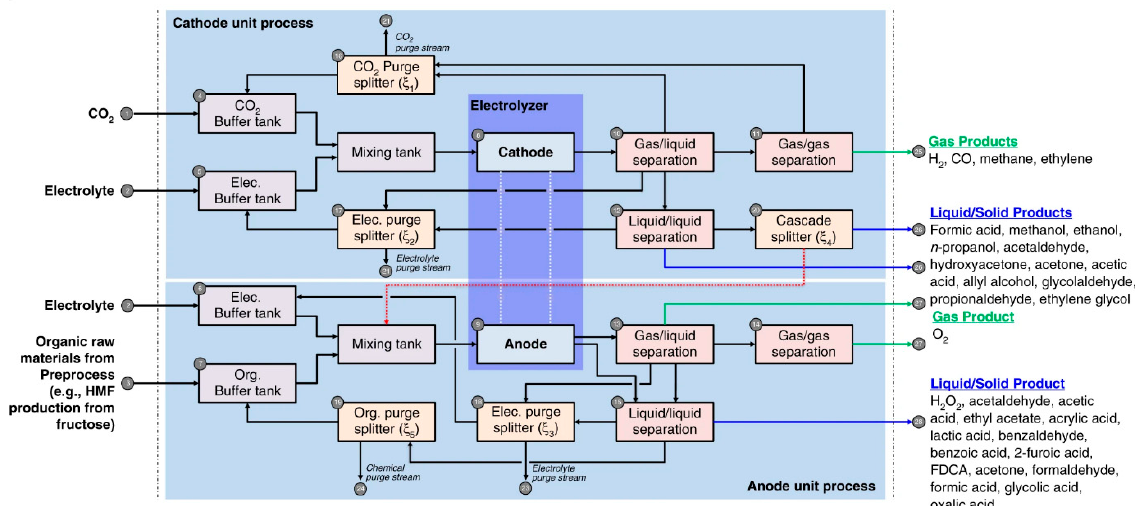
Figure 7. The superstructure of the electrochemical coproduction process is used to simultaneously consider all possible structures of the process. Reproduced with permission from ref. [7], copyright 2019, Springer Nature.